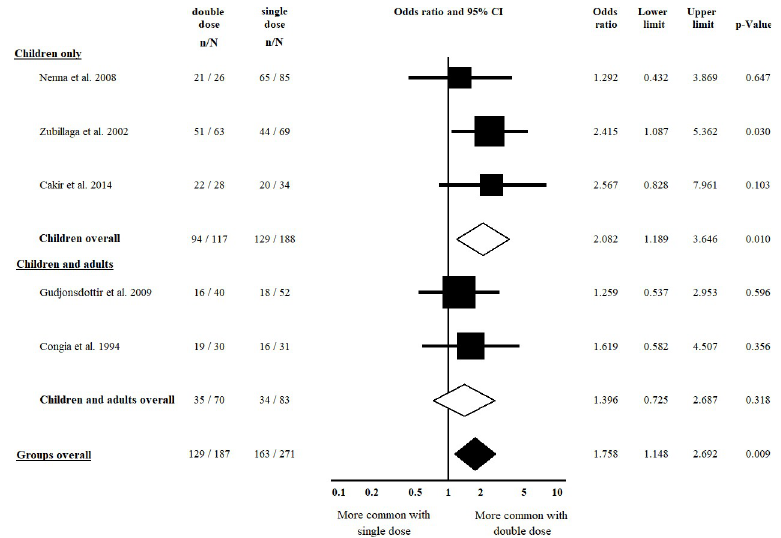
Fig 2. Odds ratios of classical presentation of CD at diagnosis with double dose vs. single dose of HLA-DQB1 � 02. Patients with a double dose of HLA-DQB1 � 02 had classical CD more frequently compared to those having a single dose. This association was more prominent in children. Heterogeneity of the groups overall: I 2 = 0.0%, p = 0.744; heterogeneity of the subgroup of children: I 2 = 0.0%, p = 0.609. CI: confidence interval.